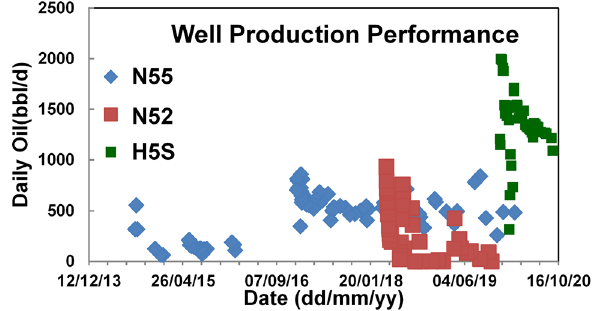
Fig. 1 Daily oil production of three hydraulically fractured wells